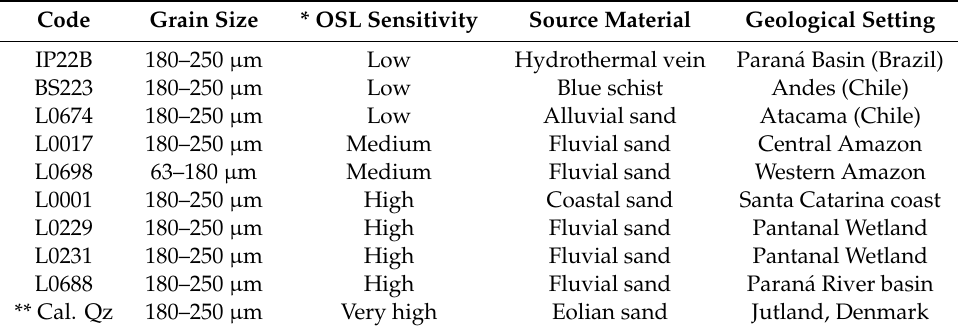
Table 1. Summary of characteristics of quartz samples used in this